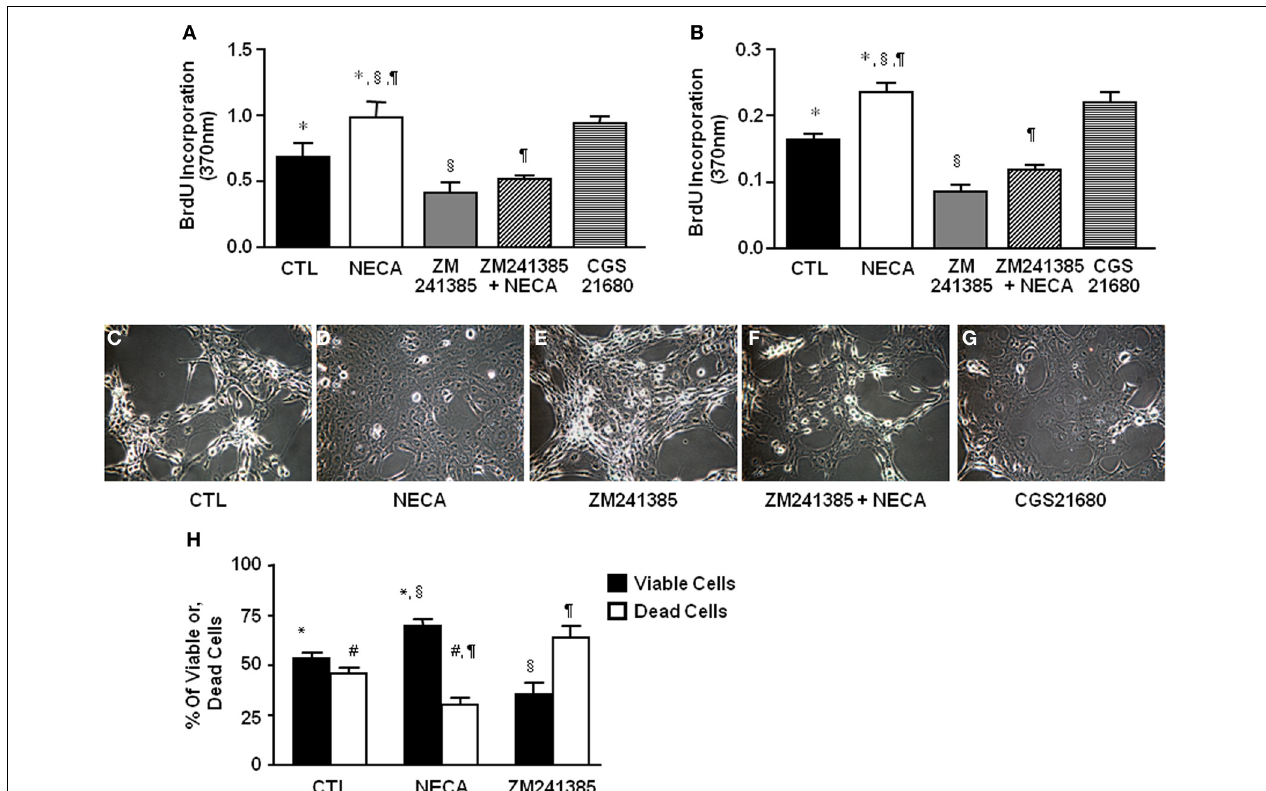
FIGURE 2 | NECA enhances BrdU incorporation and decreases H 2 O 2 -induced cell death in HSC through activation of adenosine receptor A 2A . LX-2 cells or 10 days in-vitro cultured primary rat HSC were treated with pan adenosine receptor agonist NECA (10 μ M), an A 2A receptor antagonist (ZM241385 10 μ M), or an A 2A receptor agonist (CGS21680 10 μ M) for 24h and measured BrdU incorporation. The level of BrdU incorporation was shown in (A) LX-2 cells ( ∗ = 0 . 0126, § = 0 . 00099, ¶ = 0 . 00428) and in (B) primary rat HSC ( ∗ = < 0 . 001,